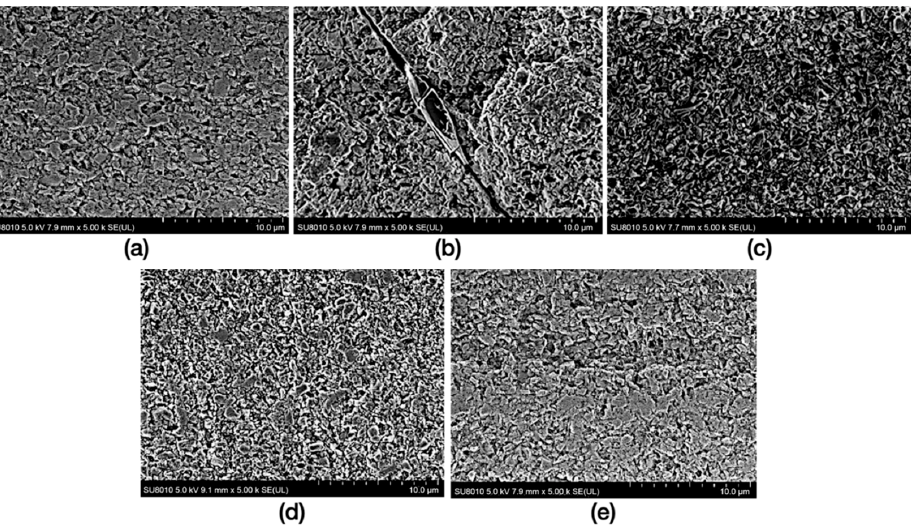
Figure 3. Scanning electron microscopy images of RNC specimens. ( a ) specimen in control group; ( b ) specimen in SB treatment; ( c ) specimen in HF treatment; ( d ) specimen in CAP-He treatment; ( e ) specimen in CAP-Ar treatment.